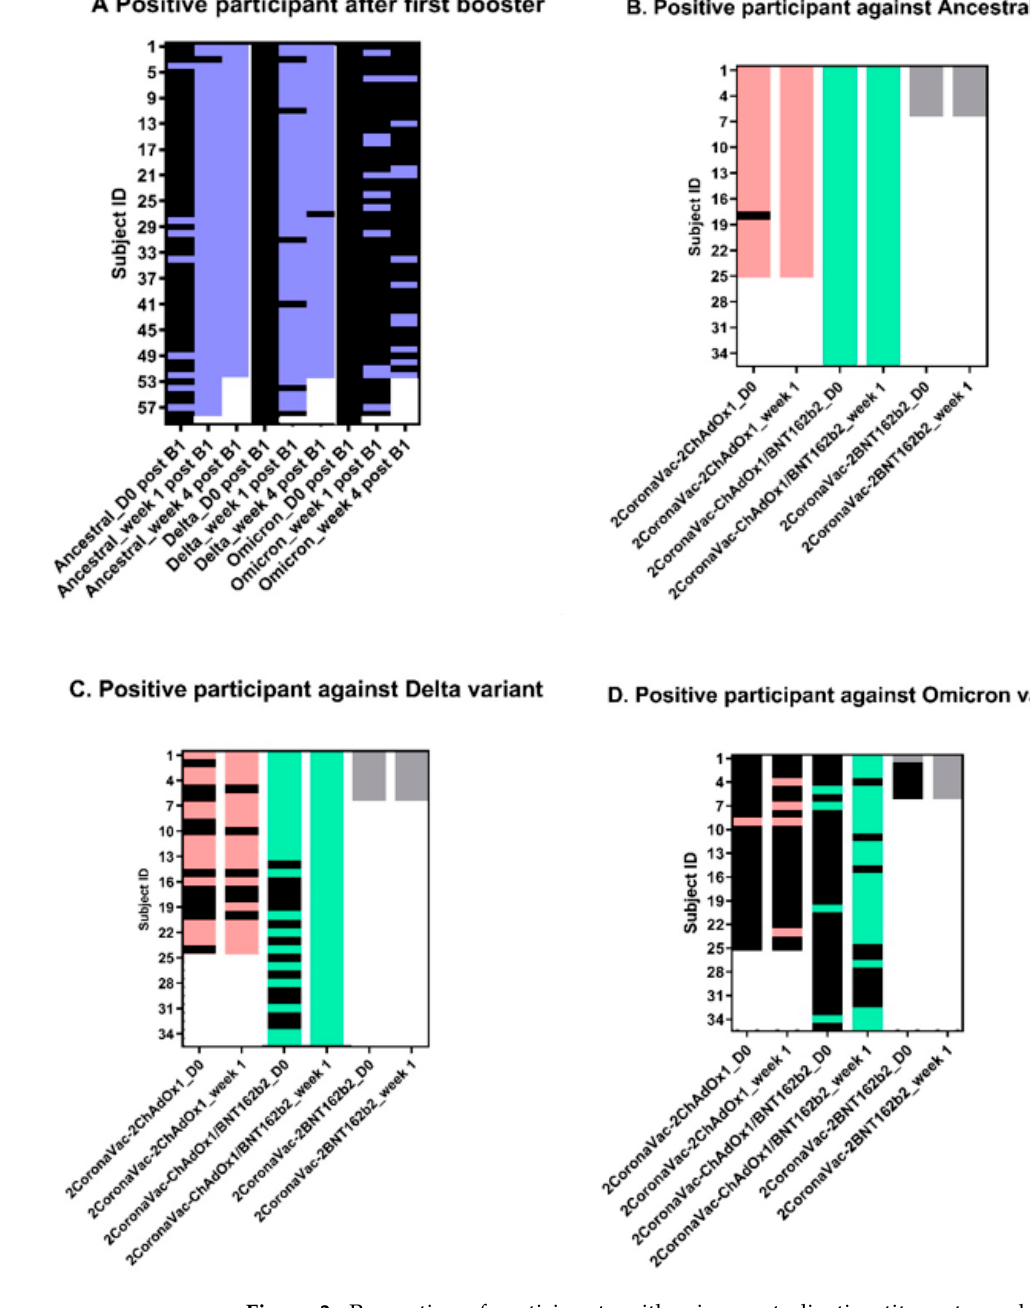
Figure 3. Proportion of participants with microneutralization titers at equal or higher than 50% ( ≥ 50%) against Ancestral, Delta, and Omicron variant at day 0 (D0) and post first or second boost-er. A group of subjects (( A ), n = 59) received a first 1ChAdOx1 booster at day 0 (D0 post B1). Blood samples were collected at day 0, week 1, and week 4 for microneutralization assay. Purple color indicates individual subjects who are positive for microneutralization and black color indicates negative microneutralization. Groups which received a second booster received 2CoronaVac-2ChAdOx1 ( n = 25), or 2CoronaVac-ChA-dOx1/BNT162b2 ( n = 36) or 2CoronaVac-2BNT162b2 ( n = 6) at day0 (D0). Blood was collected on day 0 and week 1 post second booster and used for microneutralization assays against ancestral strain ( B ), Delta variant ( C ), and Omicron variant ( D ). Rose, green, and grey colors indicate individual subjects who are positive for microneutralization in the 2CoronaVac-2ChAdOx1 ( n = 25), 2CoronaVac-ChA-dOx1/BNT162b2 ( n = 35), and 2CoronaVac-2BNT162b2 ( n = 6) groups, respectively. Black color indicates negative microneutralization.